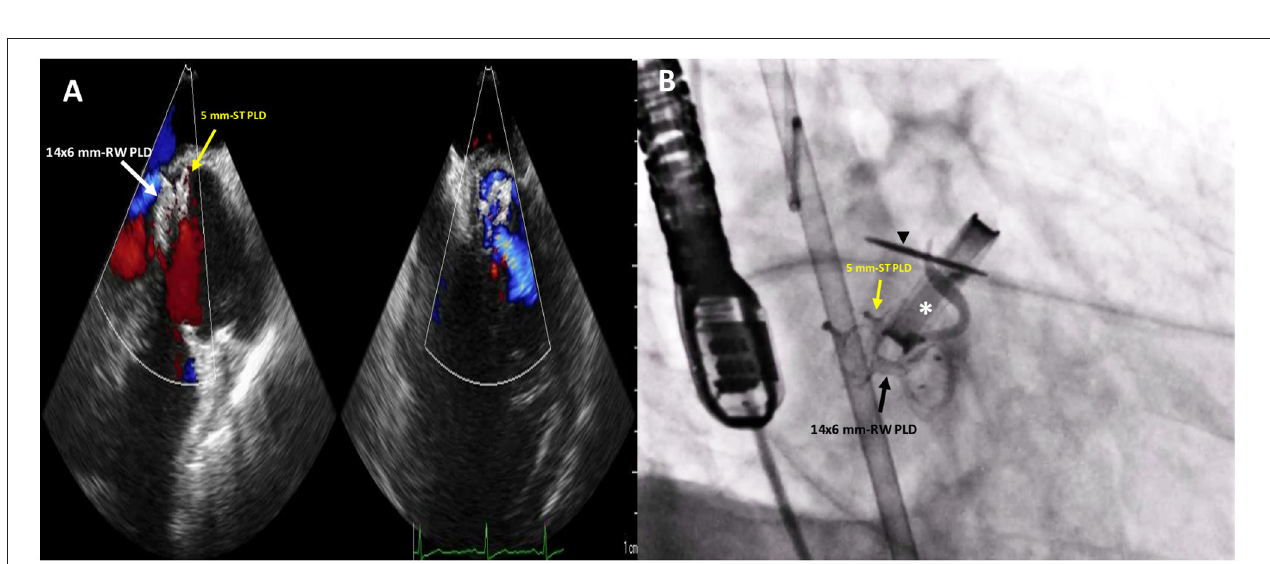
FIGURE 4 | Post-procedure 2D TTE color Doppler (A) and fluoro-angiographic (B) images showing the correct and stable position of the two PLDs not impinging on the tilting disc (black arrowhead) of the mechanical aortic valve (white asterisk) with only trivial residual regurgitant jet.